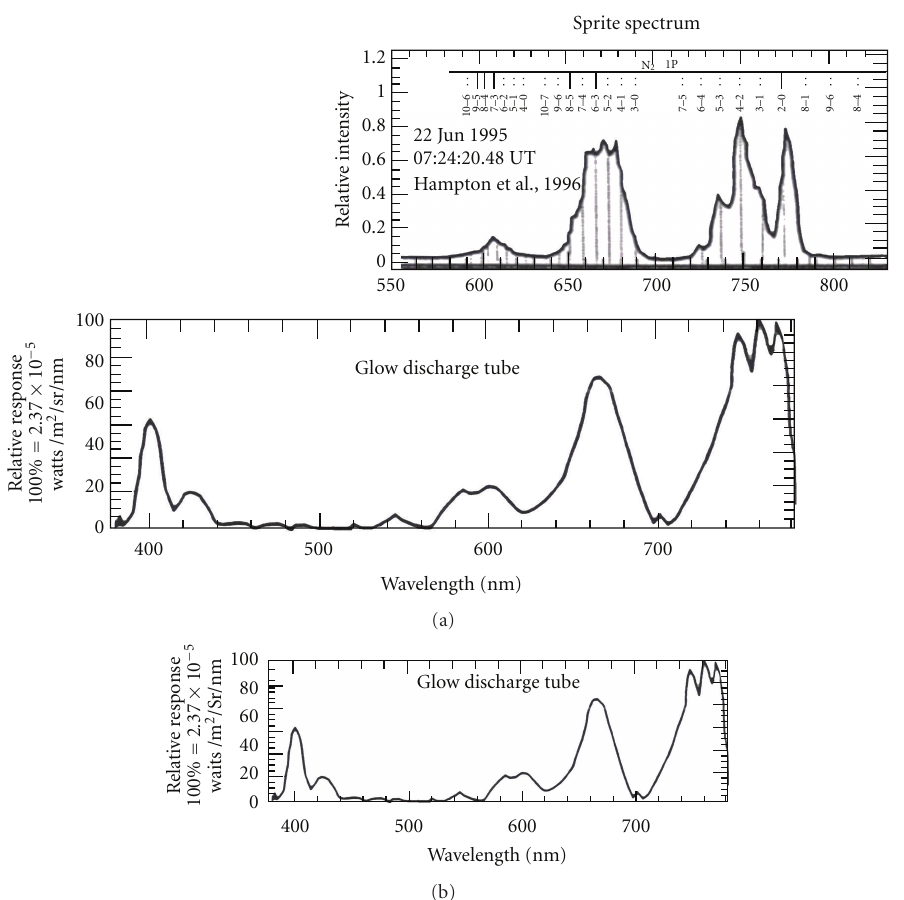
Figure 3: Comparison of optical spectra for (a) sprite in the mesosphere and for (b) the positive column of large glow discharge tube, after